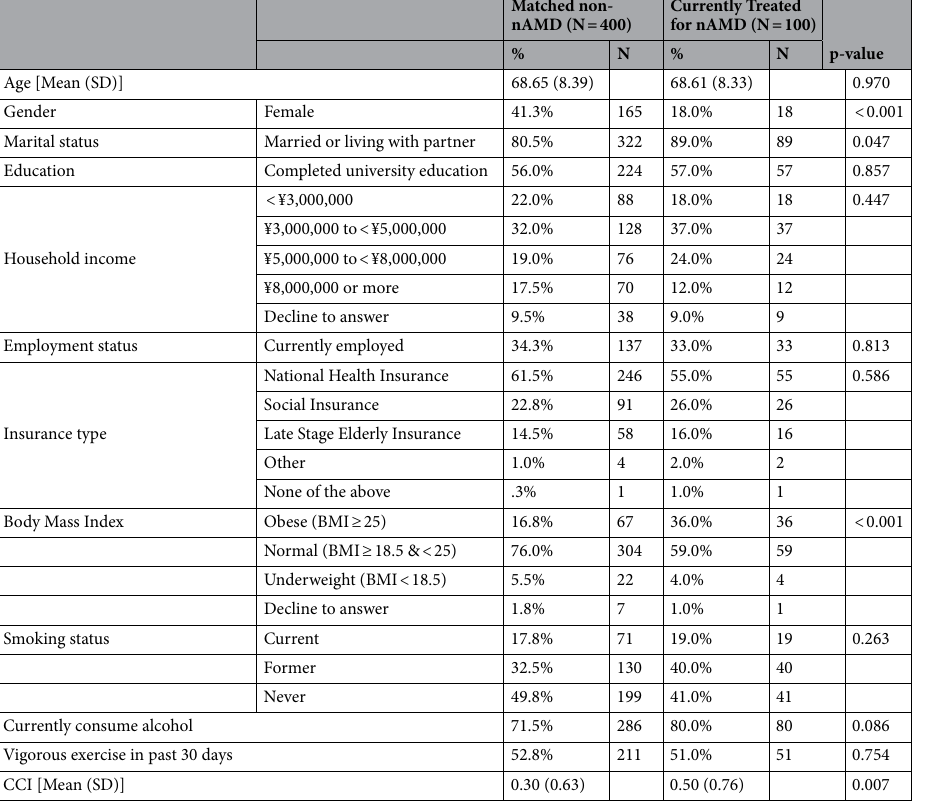
Table 1. Demographics and health characteristics of the matched non-nAMD respondents and patients currently treated for nAMD. nAMD neovascular age-related macular degeneration, SD standard deviation, BMI body mass index, CCI Charlson comorbidity